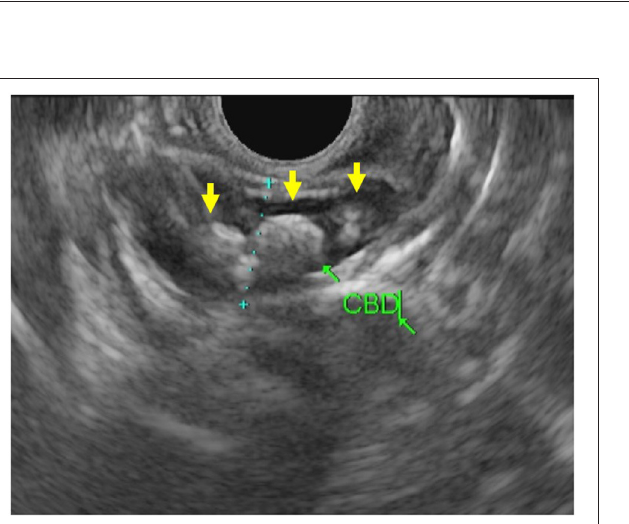
FIGURE 3 | EUS images of the common bile duct with multiple choledocholithiasis (yellow